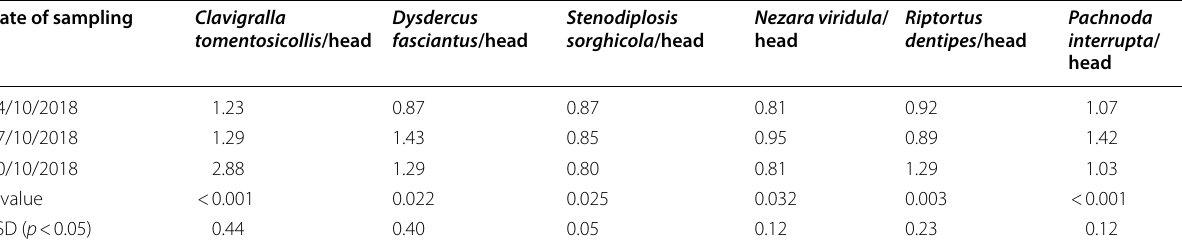
LSD least significant difference at 5% probability threshold =